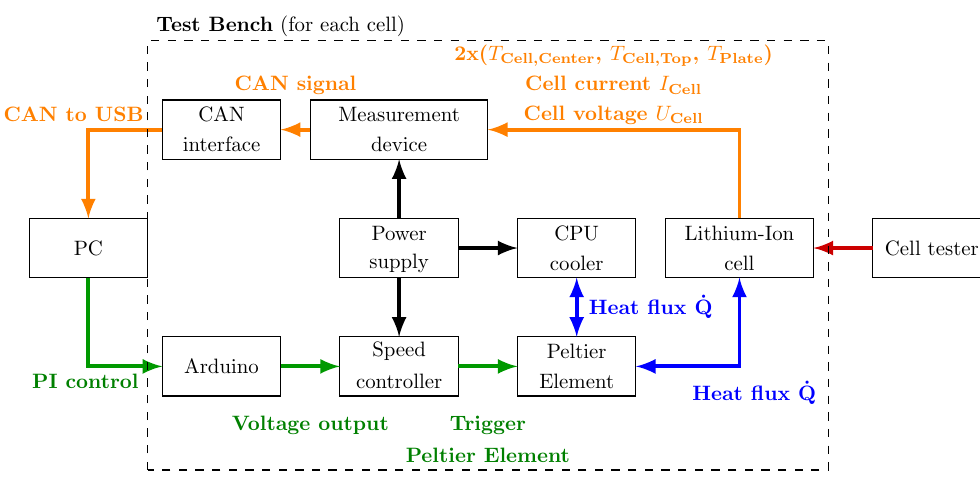
Figure 2. Schematic view of the communication and interactions of all subsystems. Table 1. Manufacturers and corresponding types of the used